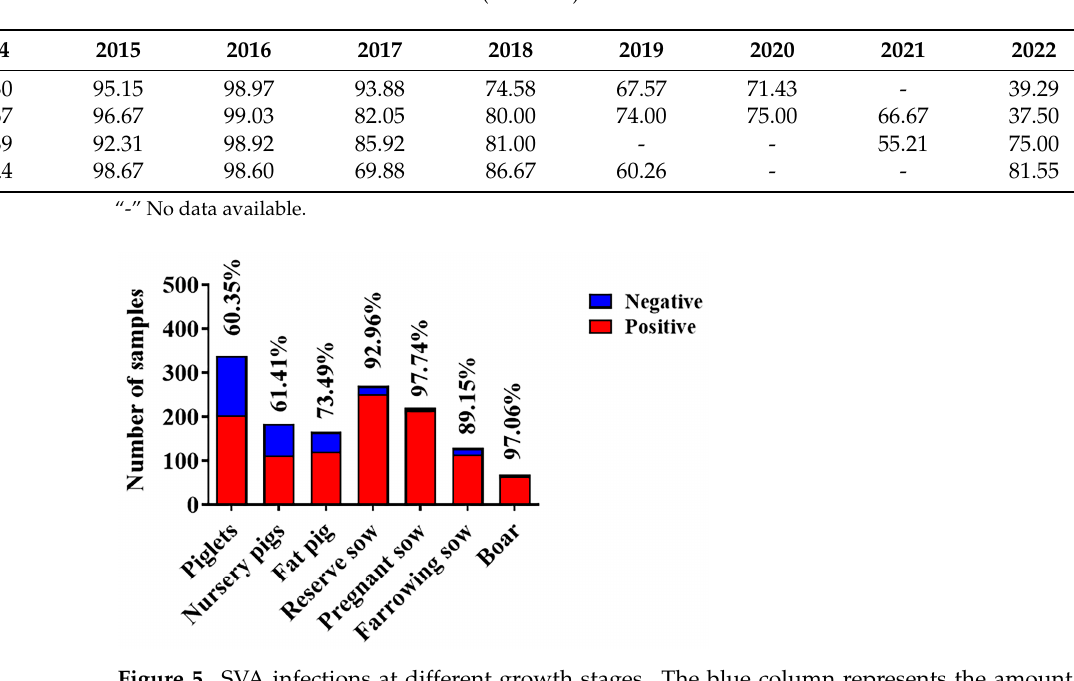
Table 4. SVA infection in East China (Ratio: %).